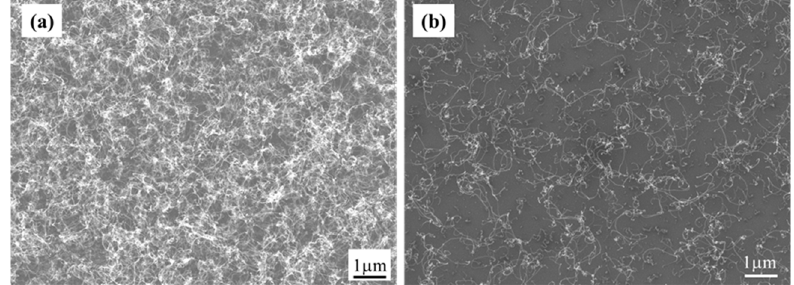
Figure 4 . The surface morphology after the CNT growth ( a ) with Al 2 O 3 layer and ( b ) without Al 2 O 3 layer.